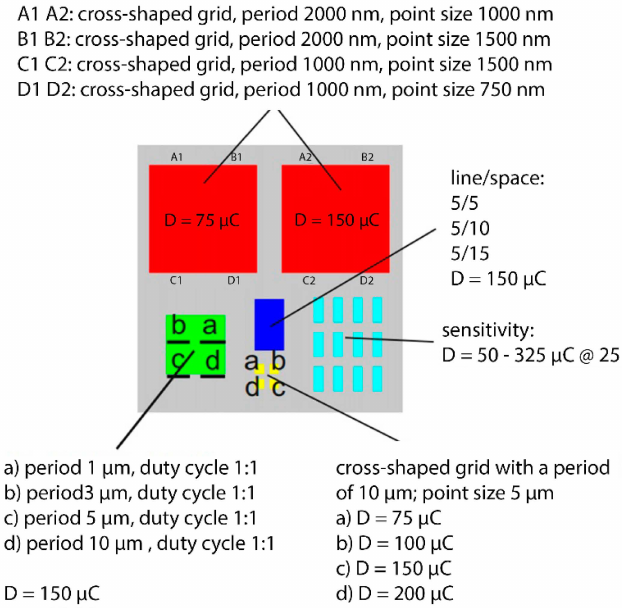
Figure 4. One of the mask motifs with multiple structures. Adapted from [15] with kind permission of Brno University of